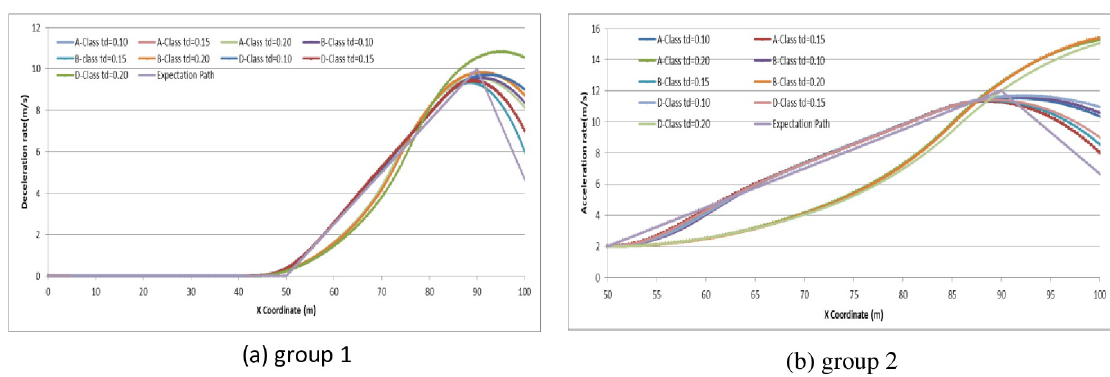
Fig 17. Comparison diagram of operation time delay in different vehicle models at initial speed = 45